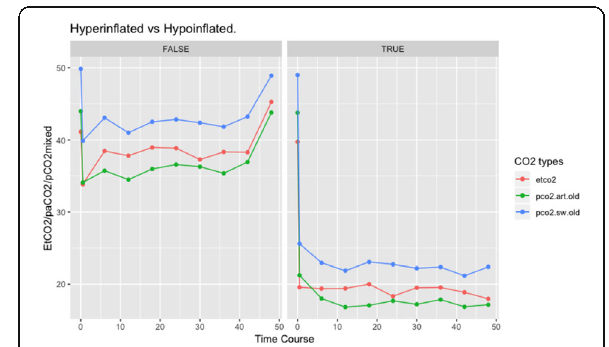
Fig. 2 (abstract 001591). Hyperinflated vs